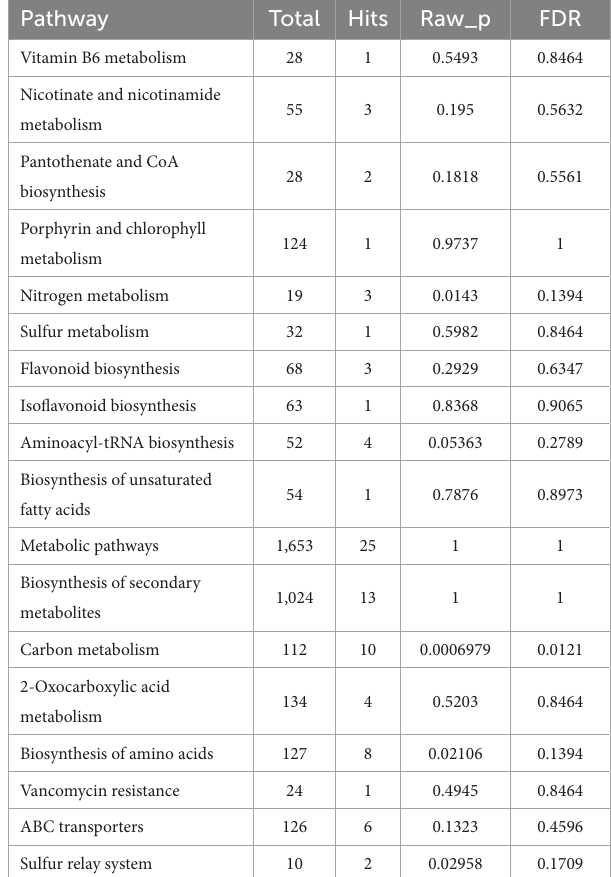
TABLE 3 Metabolic pathway